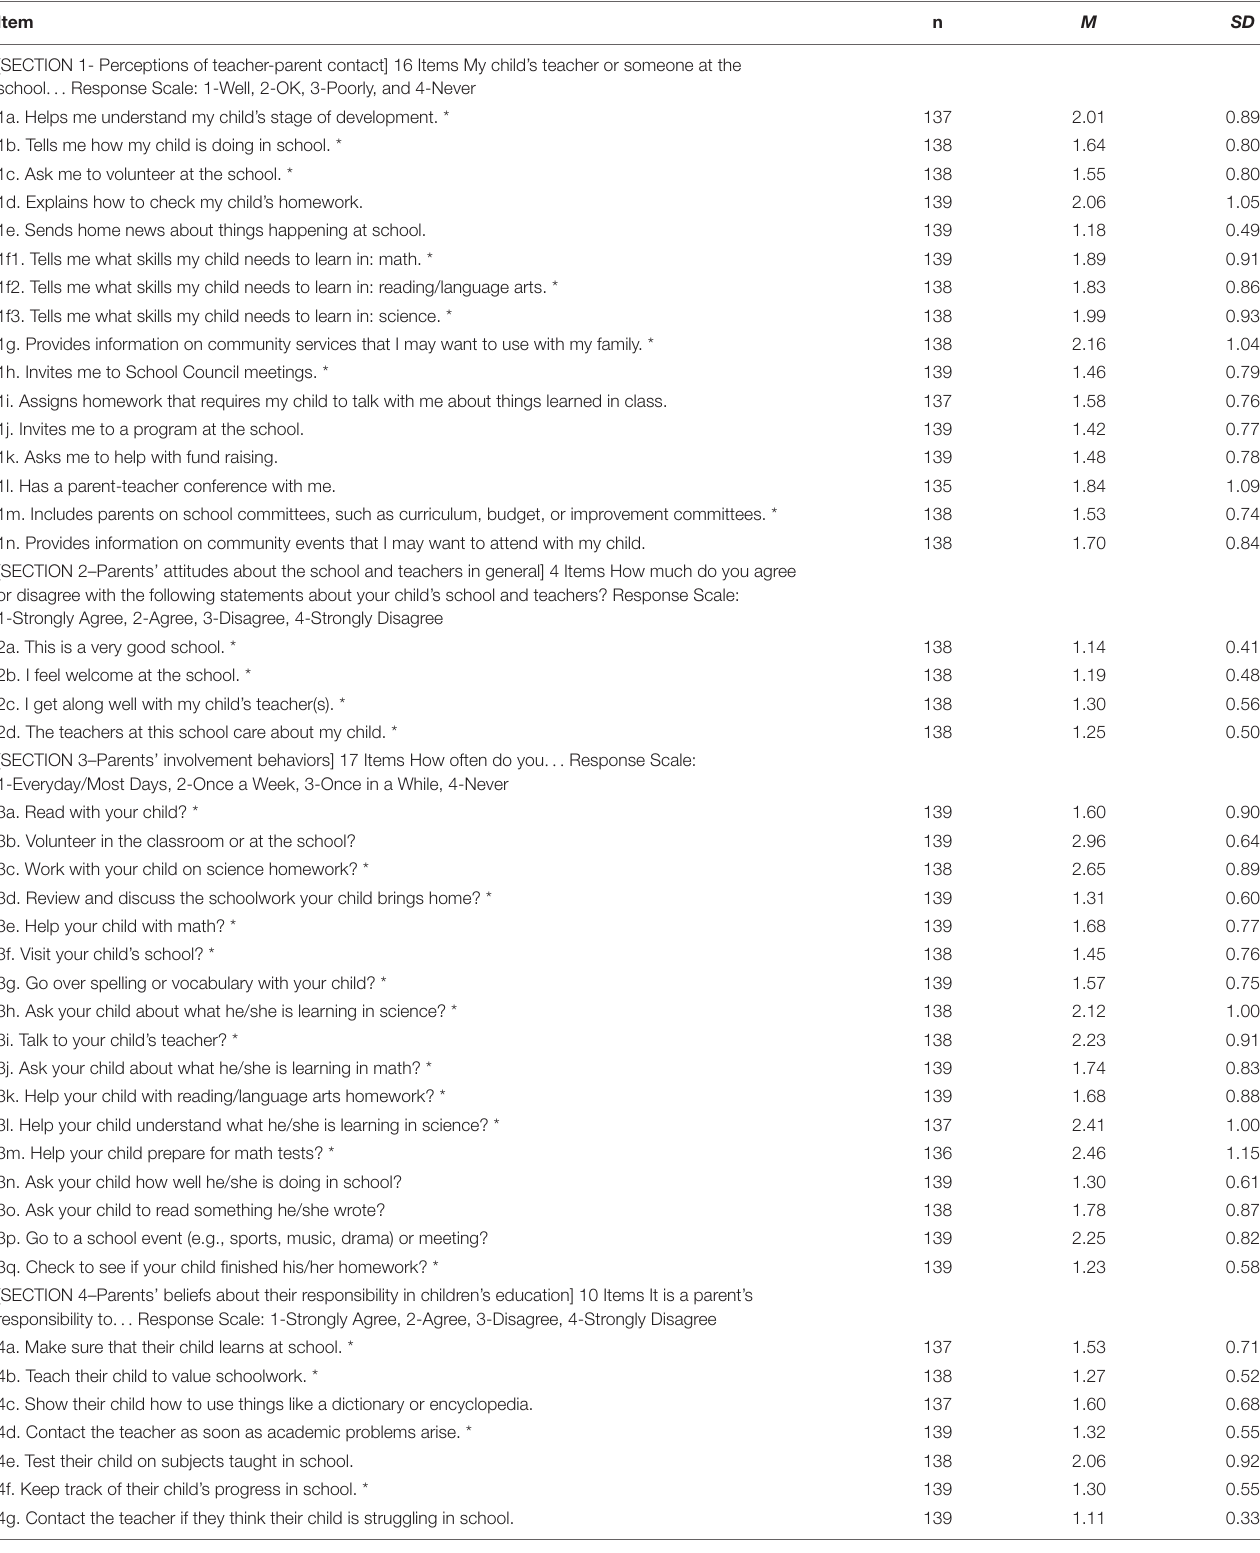
TABLE 1 | Descriptive analysis of all survey